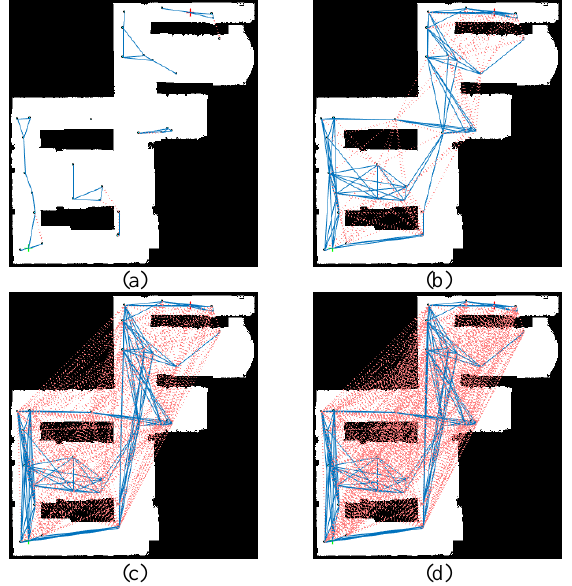
Figure 2 . Connection network under different connection distances of 0.1 (a), 0.25 (b), 0.5 (c) and 1 (d). The blue and red lines represent the good and bad edges.